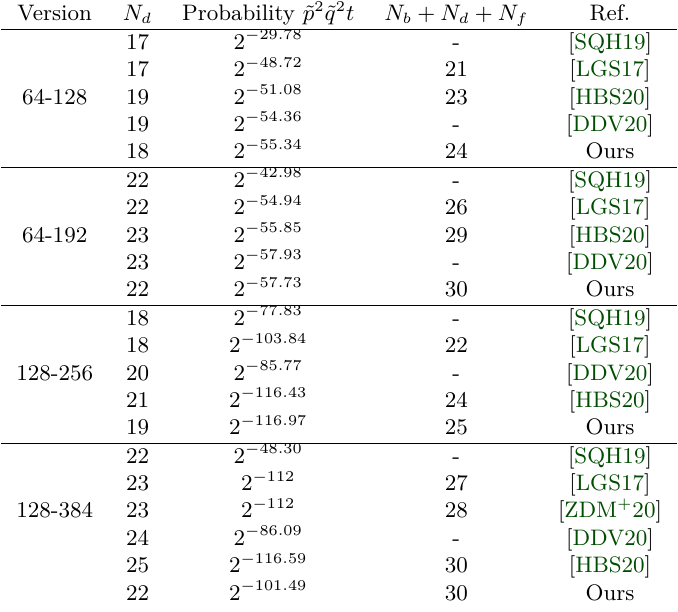
+ N + N is the total attacked number of b d f